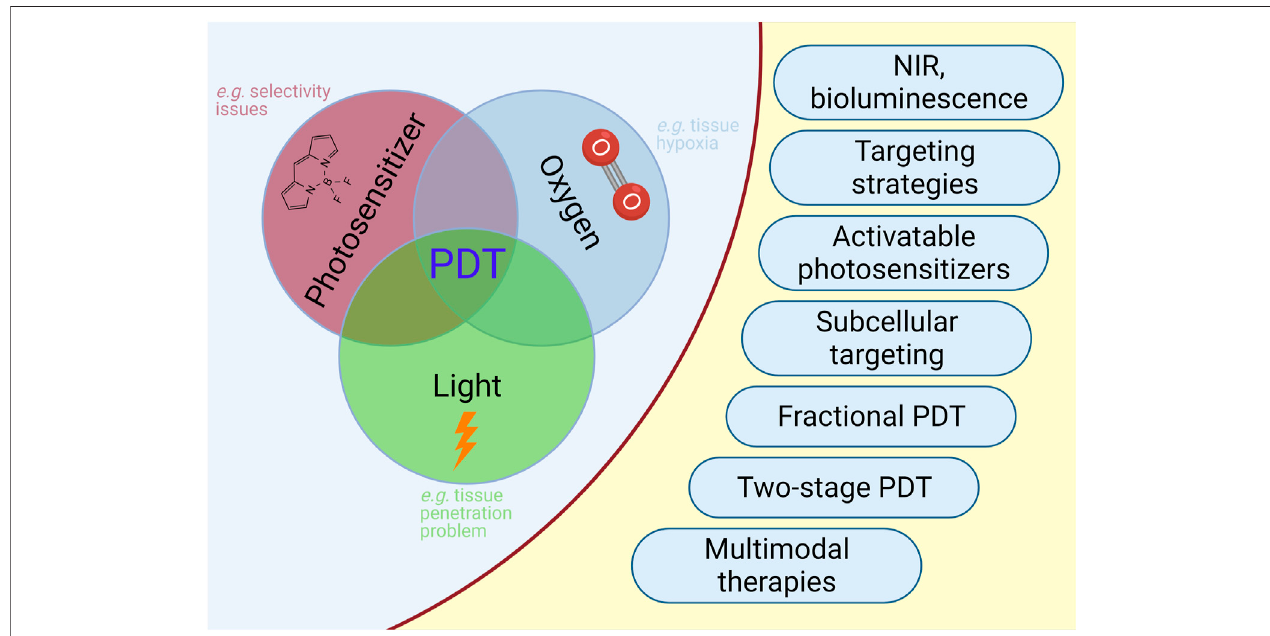
FIGURE 6 | PDT in Cancer. Selected limitations and approaches to improve outcome of PDT in cancer are illustrated.